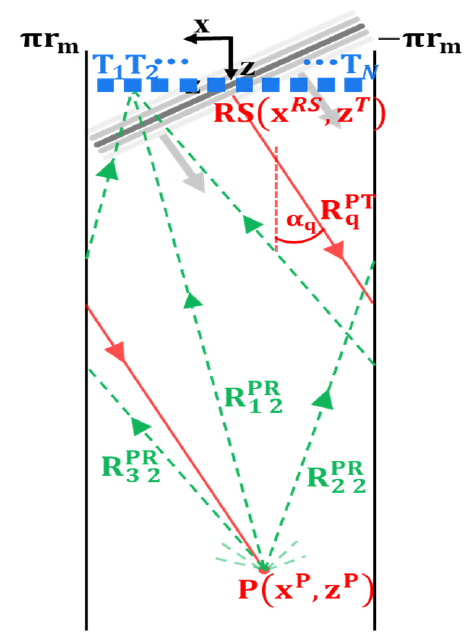
Figure 2. Schematic diagram of pipe PWI showing helical paths along which guided waves are travelling to and from a focusing point P for a q th plane wave send at an angle 𝛼 (cid:3044) . RS is the start of the incident wave travel path to the arbitrary point P, 𝑟 (cid:3040) is the mean radius of the pipe, 𝑅 (cid:3040)(cid:3037)(cid:3017)(cid:3019) is the travel path from P to the j th transducer T j via m th order helical path and 𝑅 (cid:3044) (cid:3017)(cid:3021) is the q th incident plane wave travel path to the focus point P.